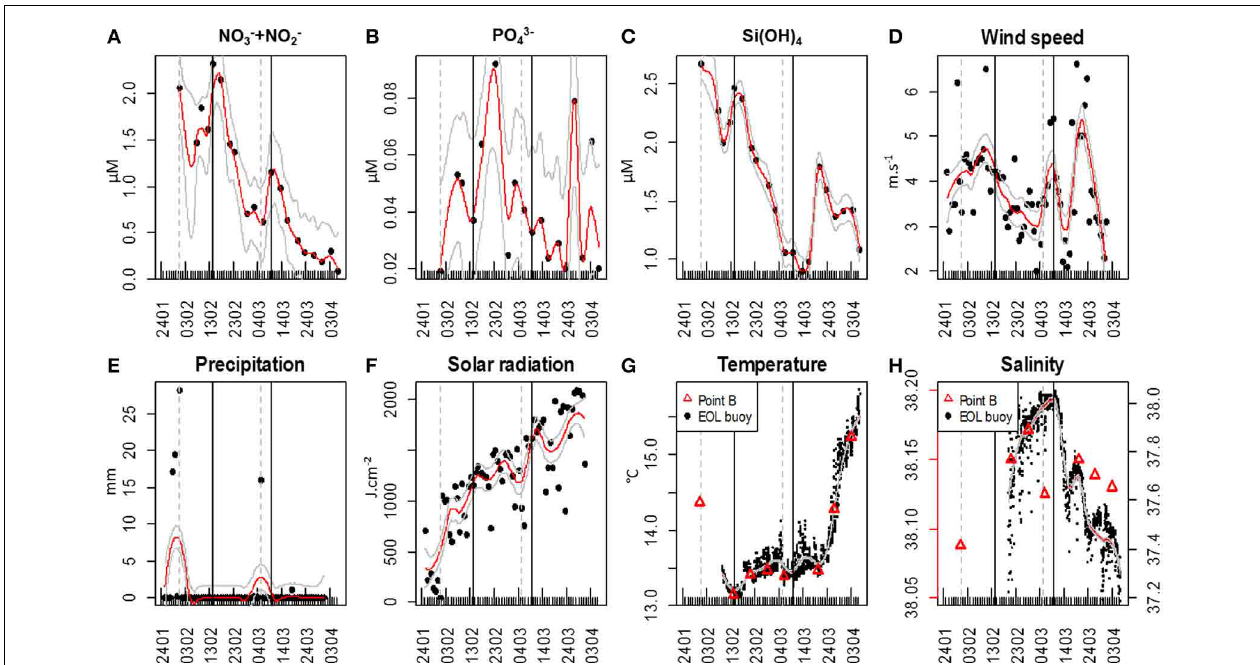
FIGURE 2 | Hydrological and meteorological characteristics in the vicinity of the EOL buoy. Meteorological data were obtained from the Nice Meteo-France airport weather station (43.648 ◦ N, 7.208 ◦ E). Red lines represent the applied loess; continuous gray lines represent the loess standard error. The gray vertical dashed lines represent the two main precipitation events and the black continuous vertical lines represent the two main Nitrate + Nitrite pulses. (A) Nitrate + Nitrite (NO − 3 + NO − 2 ) concentrations ( µ M); (B) Phosphate (PO 3 − 4 ) concentrations ( µ M); (C)